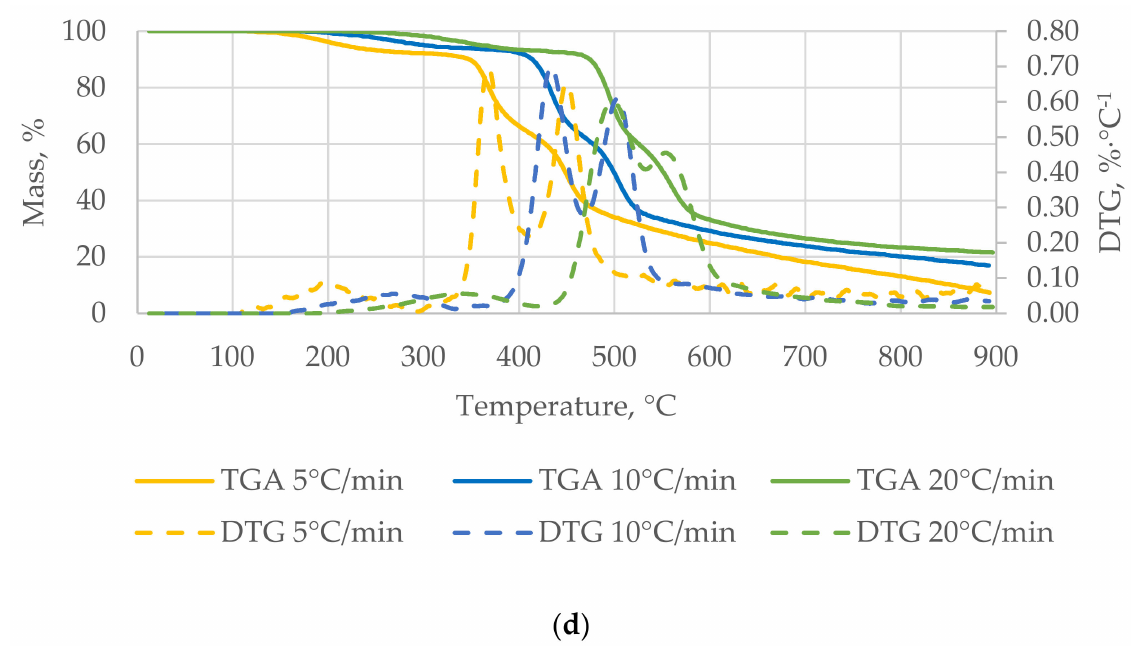
Figure 4. Thermogravimetric analysis (TGA) and derivative thermogravimetric analysis (DTG) of the walnut shells (WS) ( a ), hazelnut shells (HS) ( b ), peanut shells (PES) ( c ), and pistachio shells (PIS) ( d